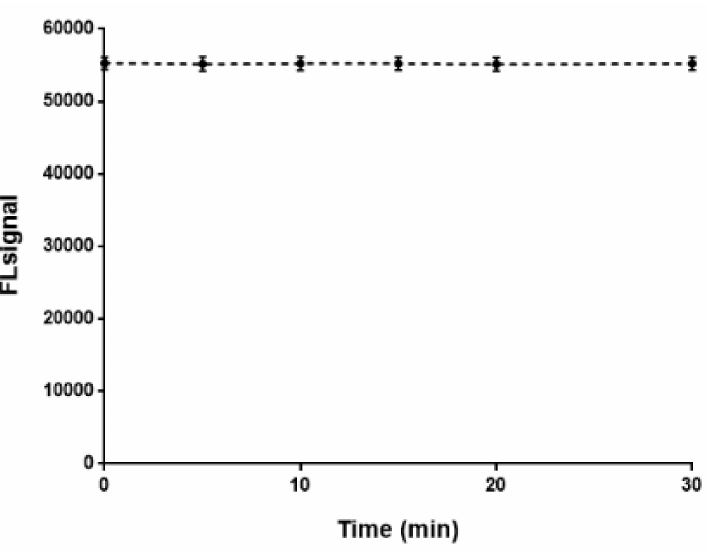
Figure 6. Fluorescence signal intensity vs. time over a 30 min period ( n =